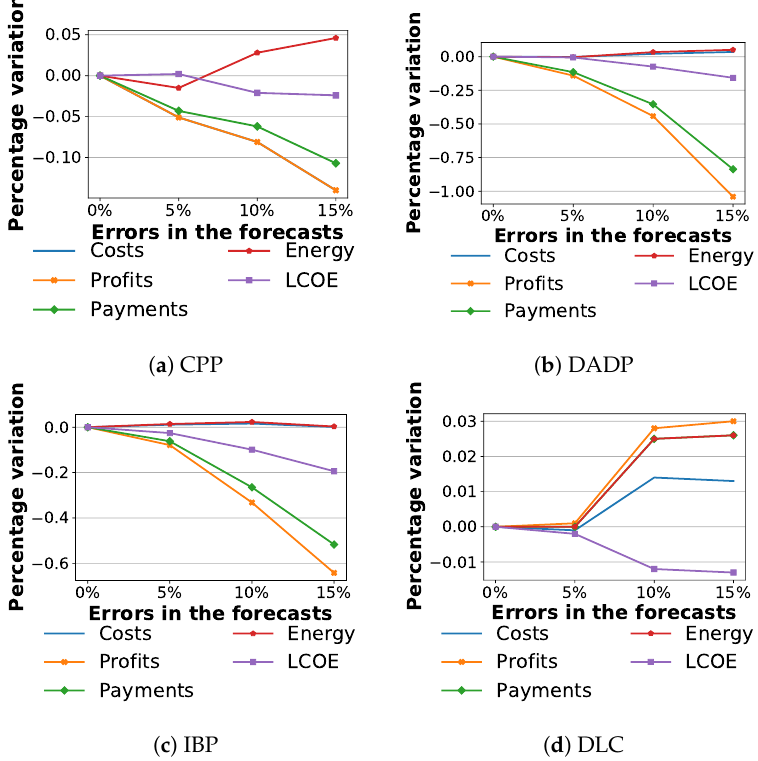
Figure 12. Effects of the forecast errors over the main results. ( a ) Forecast errors effects for a Critical Peak Pricing (CPP) DSM. ( b ) Forecast errors effects for a Day-Ahead Dynamic Pricing (DADP) DSM. ( c ) Forecast errors effects for an Incentive-Based Pricing (IBP) DSM. ( d ) Forecast error effects for a Direct Load Curtailment (DLC)